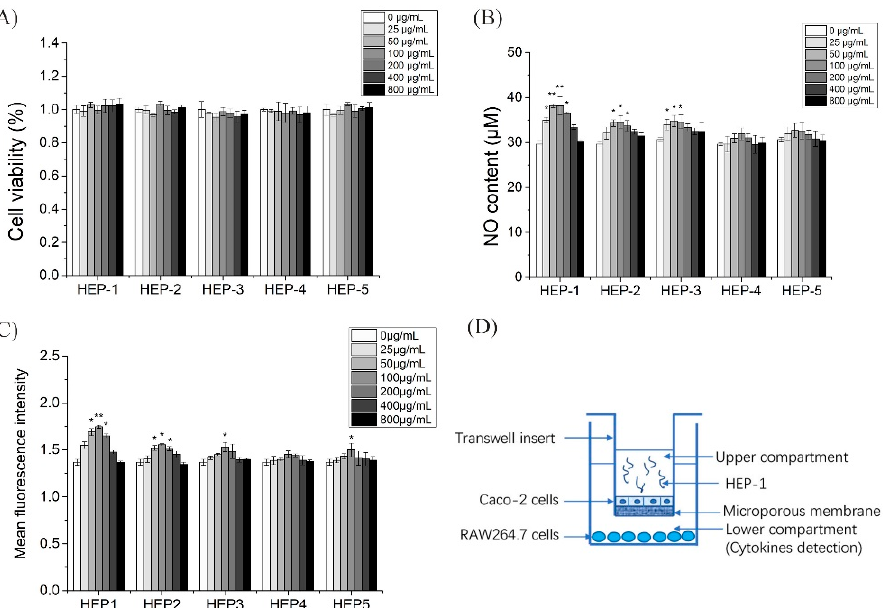
Figure 2. Effects of HEP-1, HEP-2, HEP-3, HEP-4 and HEP-5 in RAW264.7 cells. ( A ) Cell viability. ( B ) NO production. ( C ) Phagocytic activity. ( D ) The co-culture model of RAW264.7/Caco-2 cells. Data are presented as mean ± SD ( n = 3). * p < 0.05, ** p < 0.01 compared with the CK group. 3.6. Effect of HEP-1 on the Production of Cytokines in RAW264.7/Caco-2 Cells